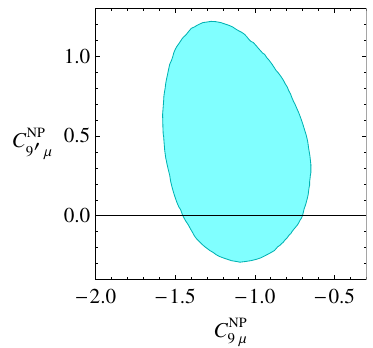
versus C np from the global analysis of b ! s(cid:22) + (cid:22) (cid:0) 9 (cid:22) 9 0 (cid:22)